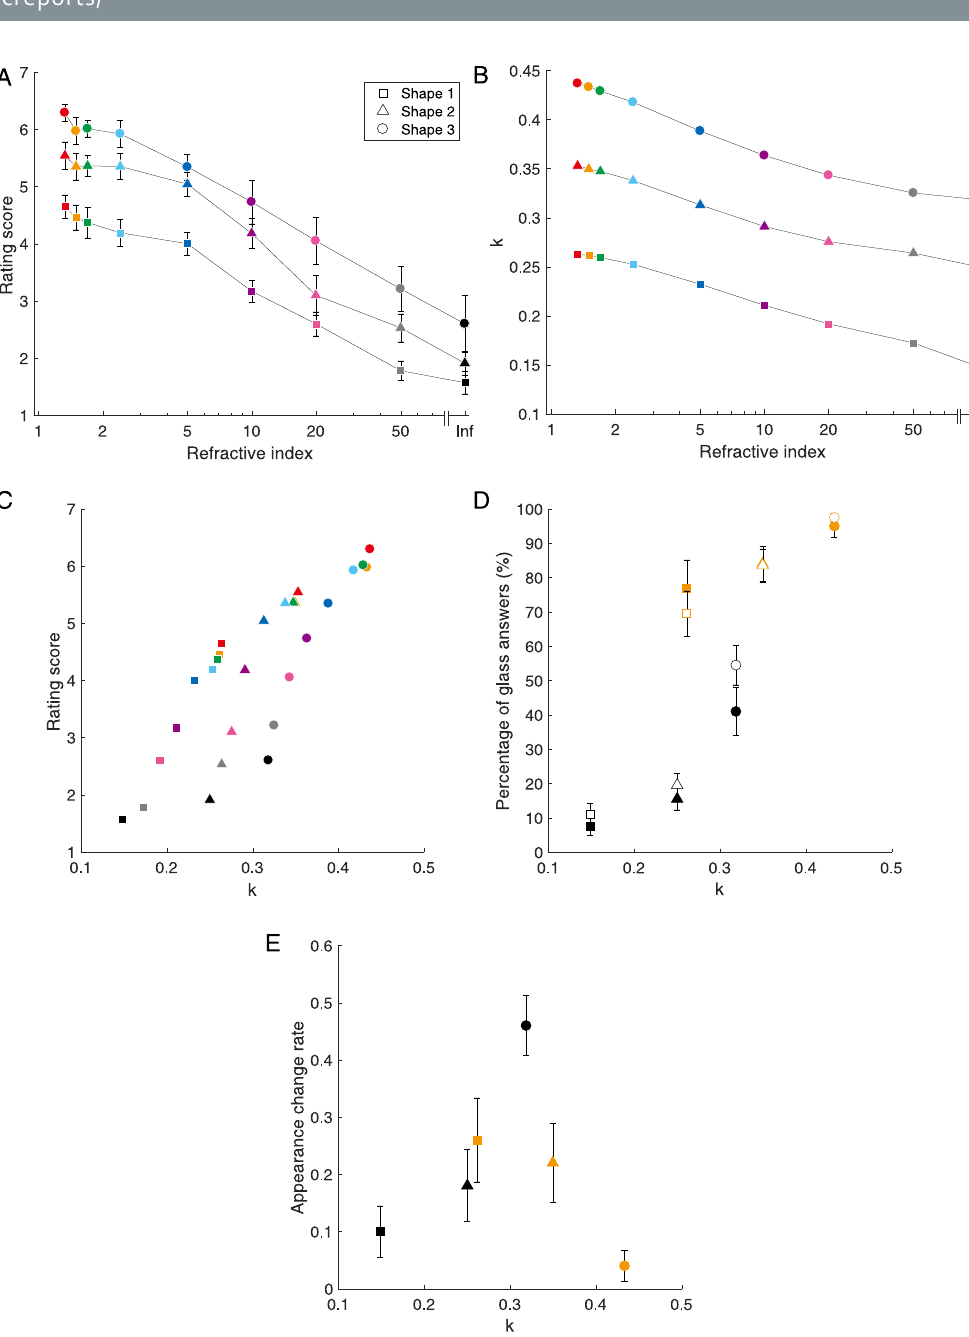
Figure 4. Developed model and its performance. ( A ) Rating score of the perceived specular reflection and transparency. The horizontal axis indicates the refractive index of the stimuli on a log scale. The vertical axis indicates the rating score on a seven-point rating system, where perceived specular reflection is one and transparency is seven. Averages and standard errors among observers were obtained. The error bars represent the standard error of the mean across all ten observers. ( B ) Model output. The horizontal axis is the same as in A . The vertical axis indicates the model output k . ( C ) Correlation between model output and ratings given by human observers. ( D ) Correlation between the model output k and the percentage of glass answers for original and upside-down stimuli under dynamic conditions. The horizontal axis indicates the model output k . The vertical axis indicates the percentage of glass answers; this axis is the same as in Fig. 2B. The filled and open symbols indicate the original and upside-down stimuli, respectively. Averages and standard errors among observers were obtained. The error bars represent the standard error of the mean across all ten observers. ( E ) The appearance change rate. The horizontal axis is the same as in ( C and D ). The vertical axis shows the rate indicating how much the material appearance changes. In ( B – E ) the symbols are the same as in A